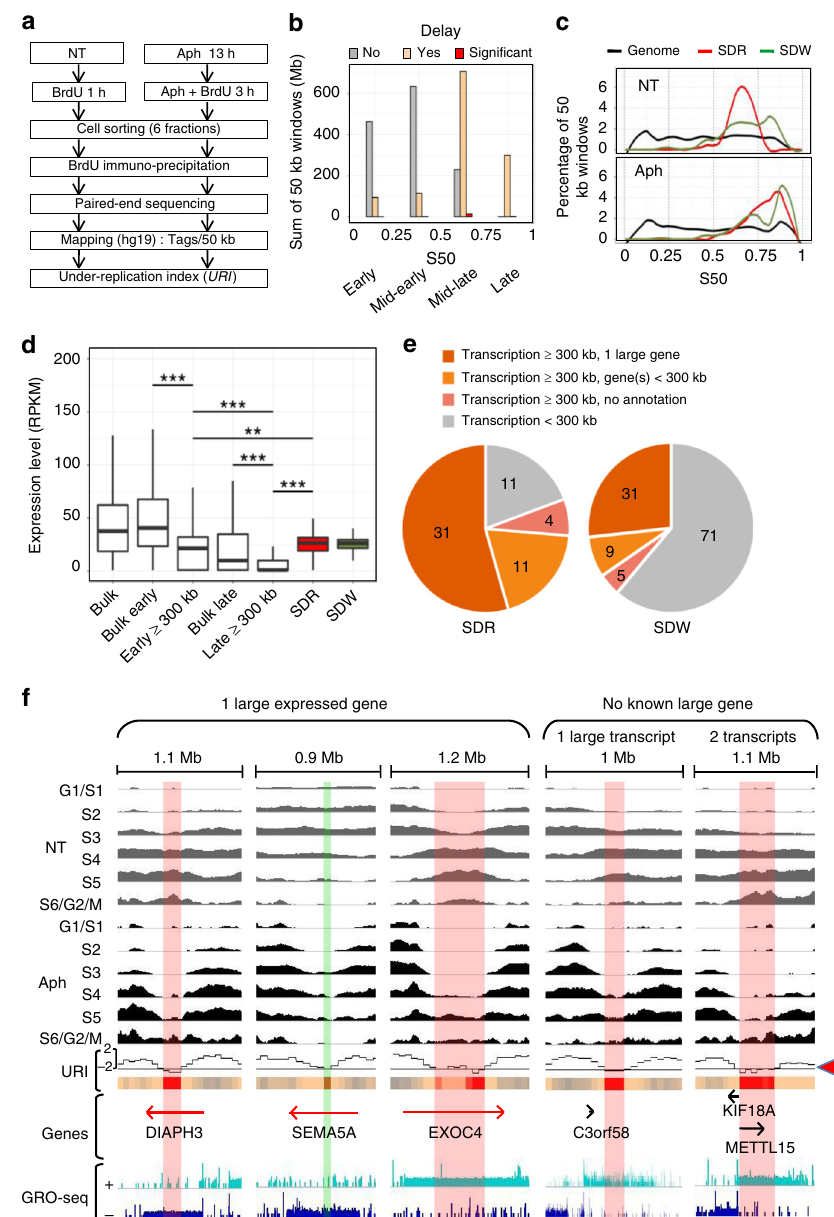
Fig. 1 Genomewide pro fi ling of replication timing identi fi es SDRs/SDWs. a Scheme of Repli-Seq experiments with untreated (NT) and aphidicolin- treated (Aph) lymphoblasts. The Under-Replication Index (URI) was calculated at 50 kb resolution ( Δ Aph-NT , Methods). b Histogram showing the sum of 50 kb windows (in Mb) displaying no delay (URI > 0, n = 26,558, 1328 Mb), low-to-moderate delay ( − 2 < URI < 0, n = 24,343, 1217 Mb), or signi fi cant delay (URI < − 2, P < 0.05, n = 330, 16.5 Mb) upon Aph treatment in four timing classes (de fi ned by the S50 on a scale from 0 to 1). c Percentage of 50 kb windows in SDRs ( n = 57), isolated SDWs ( n = 116), and along the genome ( n = 56,783) as a function of S50. These percentages were computed within each bin (bin size = 0.01) then Loess smoothed ( α = 0.25). For SDRs, the values correspond to the mean timing of all 50 kb windows in each SDR. d Boxplot (bounds of box: 25th and 75th percentiles; centre line: median) showing the gene expression level distribution relative to their replication timing. For genes > 50 kb, the timing values correspond to the mean timing of all 50 kb windows enclosed in each gene. The expression levels (RPKM, Methods) were measured by GRO-Seq 29 for all expressed genes (Bulk, n = 15,204), all early-replicating (S50 < 0.5, n = 13,257), all late-replicating (S50 ≥ 0.5, n = 1947), the subset of early-replicating ( n = 315) or late-replicating ( n = 304) genes ≥ 300 kb free of SDR/SDW, and for genes harbouring an SDR ( n = 54) or an SDW ( n = 39) (Kolmogorov – Smirnov test: ** P < 0.01; *** P < 0.001). e Pie-chart showing the numbers of SDRs or SDWs associated with the indicated classes of transcripts. f Representative examples of SDRs/SDWs nested in large transcribed domains. The Repli-Seq pro fi les (NT and Aph) were normalized to the same background level (Methods). The URI pro fi le is shown with red arrowhead pointing to − 2 threshold (Methods), aligned with the corresponding heat-map (colours as in b ). Genes and the GRO-Seq pro fi les on the Watson ( + ) and Crick ( − ) strands are shown. The SDRs (red vertical bars) and SDW (green vertical bar) are indicated. The genomic regions displayed are from left to right: chr13:61-61.1; chr5:8.8-9.7; chr7:132.8-134; chr3:143.4-144.4; chr11:27.7-28.9 Mb. Source data are provided as a Source Data fi